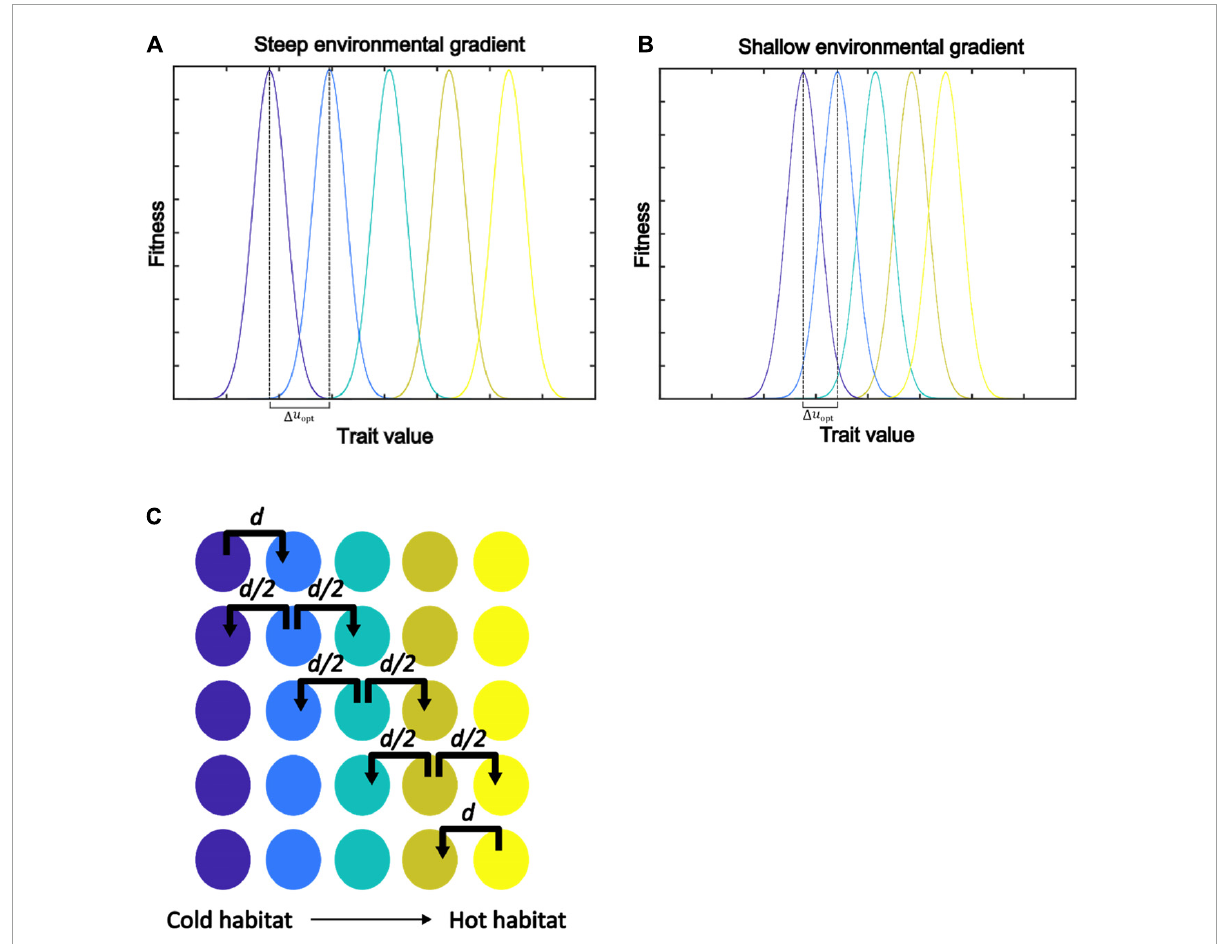
FIGURE2 Illustration of the spatially explicit model with linearly spaced habitats, distinct environmental gradients (A,B) , and stepping-stone dispersal (C) . Panels (A,B) represent steep and shallow environmental gradients (e.g., temperature), respectively. (cid:49) u opt denotes the difference between the mean environmental conditions in each of the habitats. (A) With a steep environmental gradient, (cid:49) u opt is larger and species have low or zero fitness in neighboring habitats. (B) With a shallow environmental gradient, (cid:49) u opt is smaller and species optimized in one habitat may have positive fitness in the neighboring habitat. (C) Stepping-stone dispersal allows individuals to disperse to the adjacent habitats only. For each generation, a proportion d of the residents